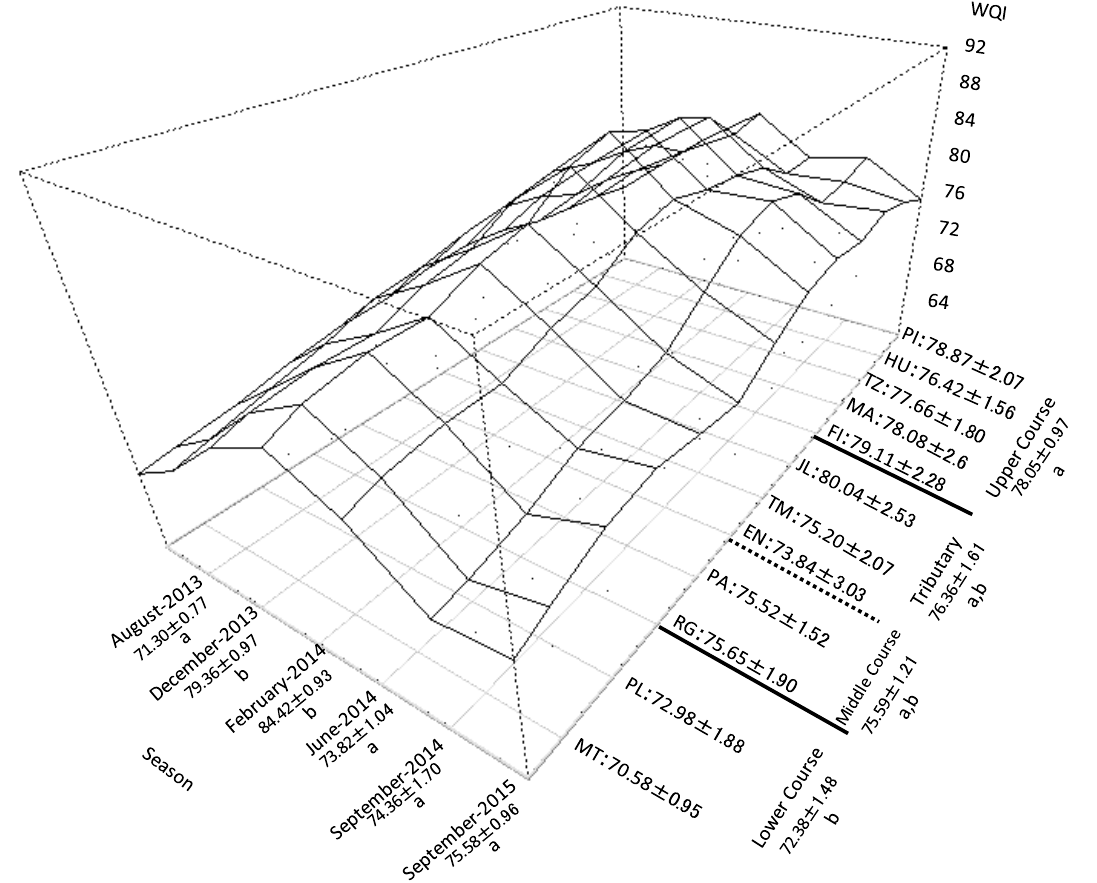
Figure 4. Mean values of water quality index (WQI) by study site, season, and river portion. a ≠ b ( p < 0.05).